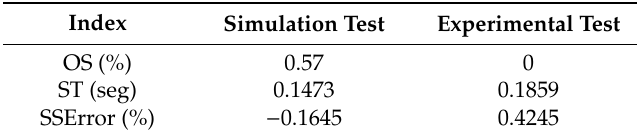
Table 2. Performance of the closed loop system: overshoot (OS), settling time (ST), and steady-state error